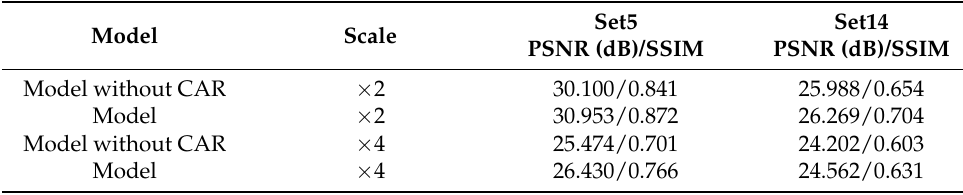
Table 3. Comparison of results for modules with and without CAR.